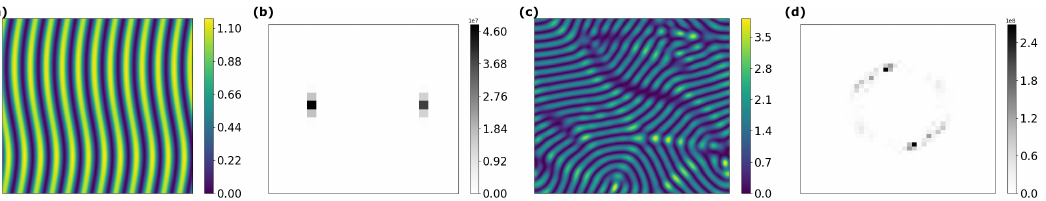
Figure 13. Examples for numerically obtained structures. ( a , c ): Near field intensity structures. ( b , d ): Corresponding far field intensity displaying Fourier spectra. Parameters B x = 0.76 G, B y = B z = 0, b 0 = 130, ∆ = − 12 Γ , pump intensity 6.8 mW/cm 2 . The difference between the two realization is the size of the integration domain relative to the lattice period.